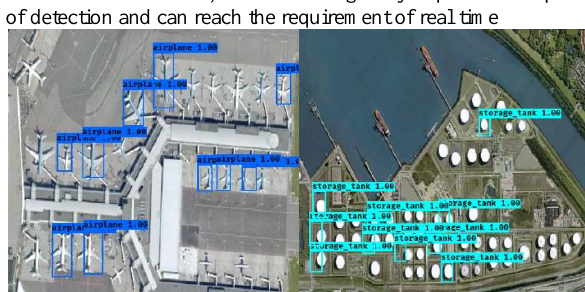
Table 3. Testing time of four object detection methods. As is shown in Table 3, YOLO model greatly improved the speed